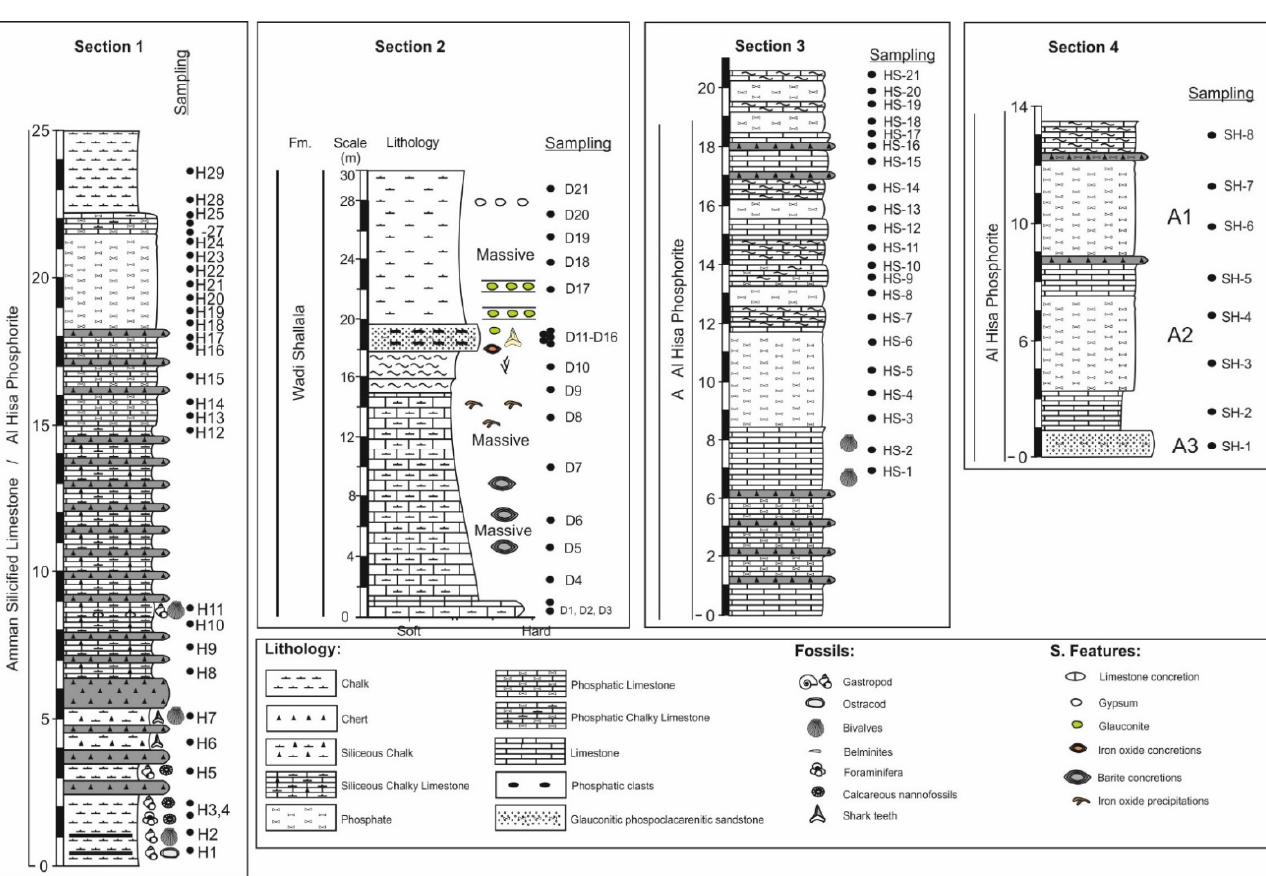
Figure 3. Columnar sections show the main lithological and fossil contents in sections